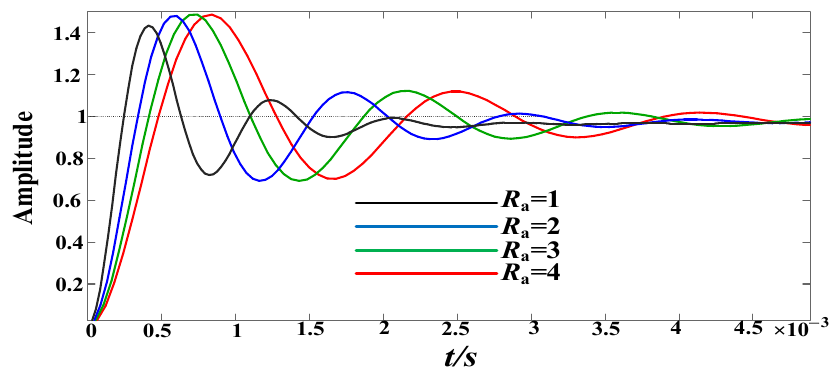
Figure 7. f ( s ) under different R a . Figure 7. 𝑓(𝑠) under different 𝑅 (cid:2911) .